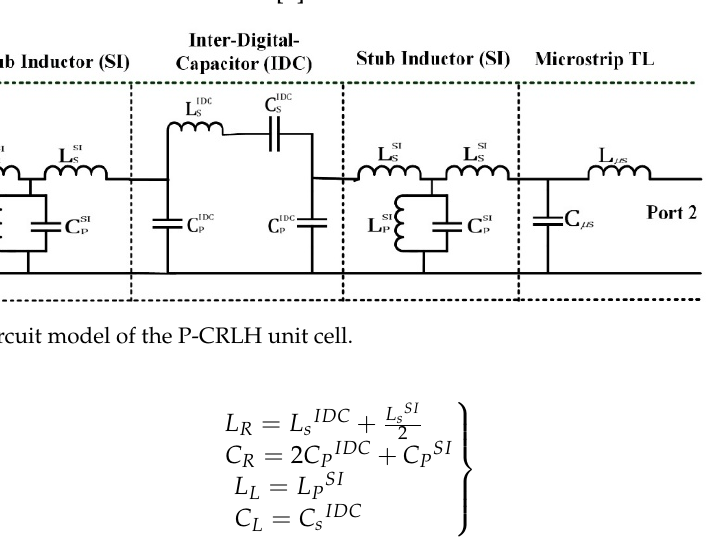
Figure 1. ( a ) P-CRLH unit cell top view (𝐴𝑙𝑙 𝑑𝑖𝑚𝑒𝑛𝑠𝑖𝑜𝑛𝑠 𝑎𝑟𝑒 𝑖𝑛 𝑚𝑚:𝐿 (cid:3020) = 8, 𝑊 (cid:3020) = 1, 𝑊 (cid:3033) = 0.3,𝐿 (cid:3033) = 6, 𝐿 (cid:3091)(cid:3046) = 7.6, 𝑊 (cid:3091)(cid:3046) = 1.8,𝑑 = 0.6,𝑊 (cid:3034) = 9, 𝐿 (cid:3034) = 22, 𝑆 = 0.2) ; ( b ) P-CRLH unit cell 3D view.